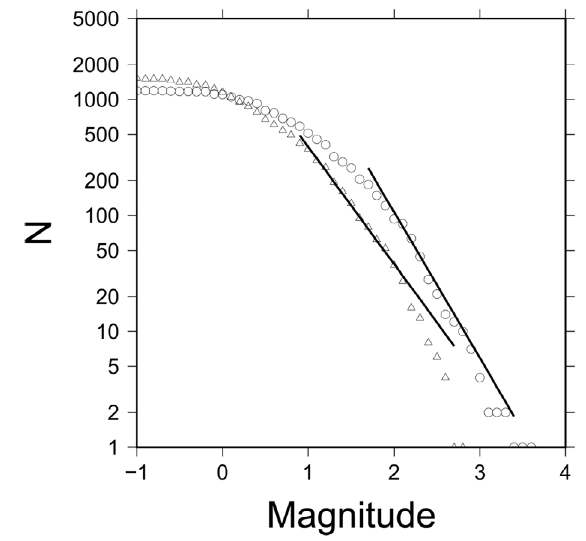
Figure 8. Time-depth distribution of the strain release. In A we plot events in a time-depth graphic. Symbol sizes are proportional to magnitude as for Figure 6. In B we represent the strain release as a function of time and depth. In C we show the strain release as a function of the depth. The arrows in B and C point to the strain re- lease spike related to the October 9, 1999, (M=3.6) event.